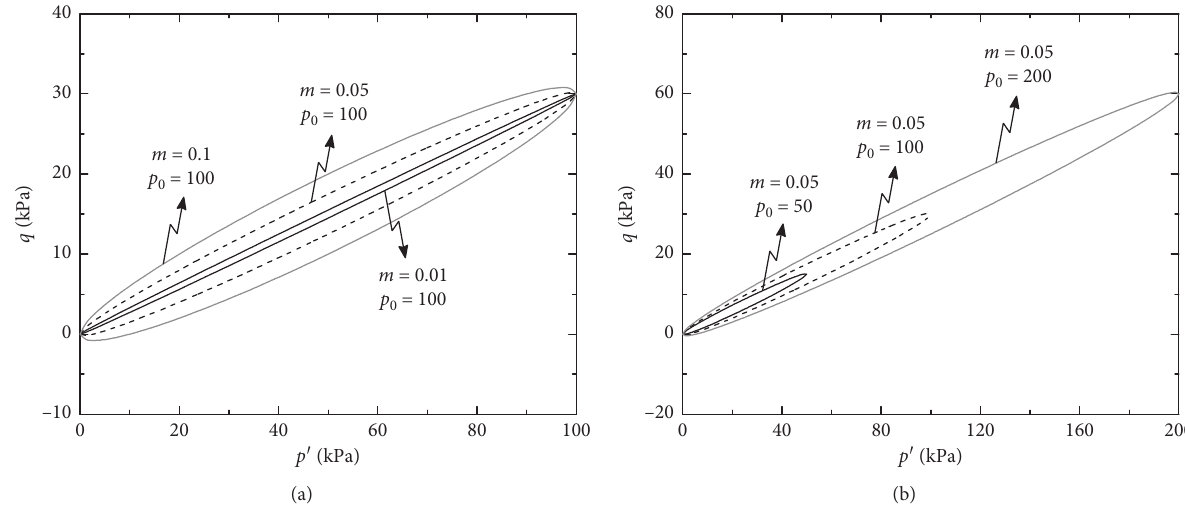
Figure 4: Dependency of an elliptical yield surface [23] on parameters (a) m and (b) p